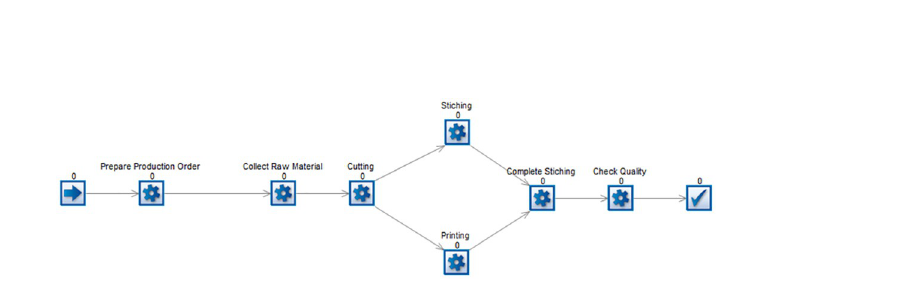
Fig 10. Simul8 Model for Shirt Manufacturing.